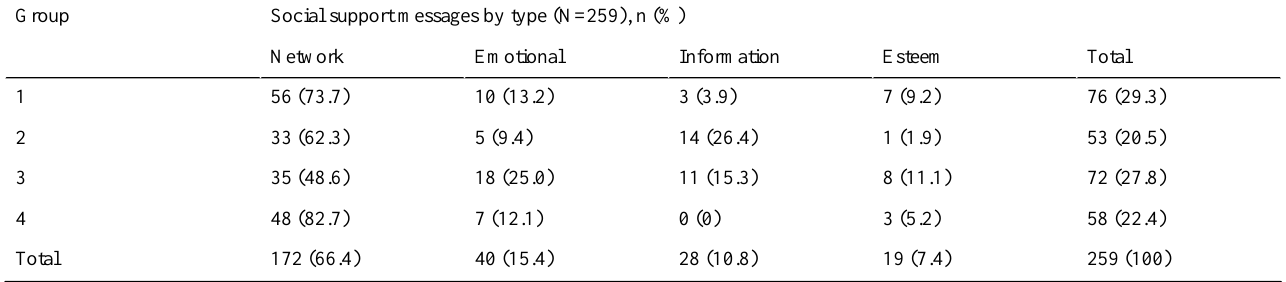
Table 4. The frequency of each type of social support message provided by each group. Social support messages by type (N=259), n (%)Group